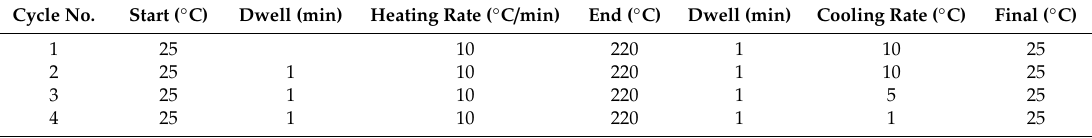
Table 2. DSC experiment protocol to examine the effect of cooling rate on processing window. Cycle